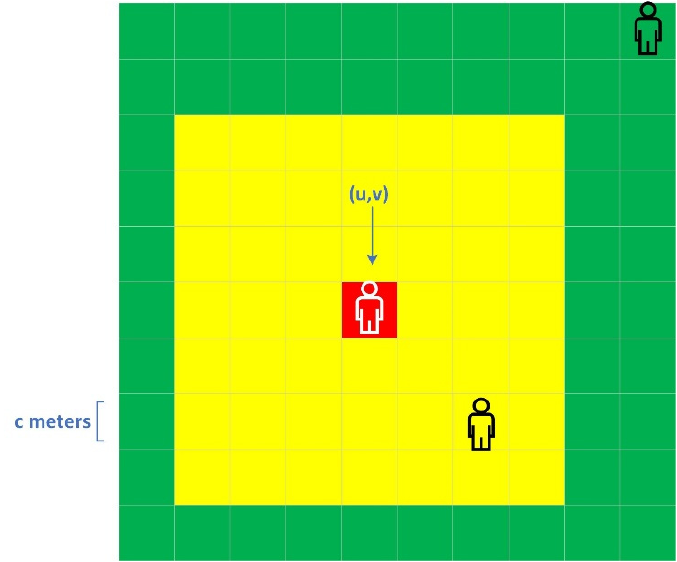
Figure 4. The position of the student in red is denoted as (𝑢, 𝑣) .